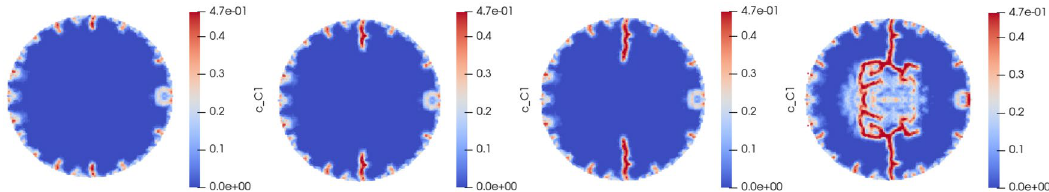
Figure 8. Shear energy change and damage of intact rock materials.